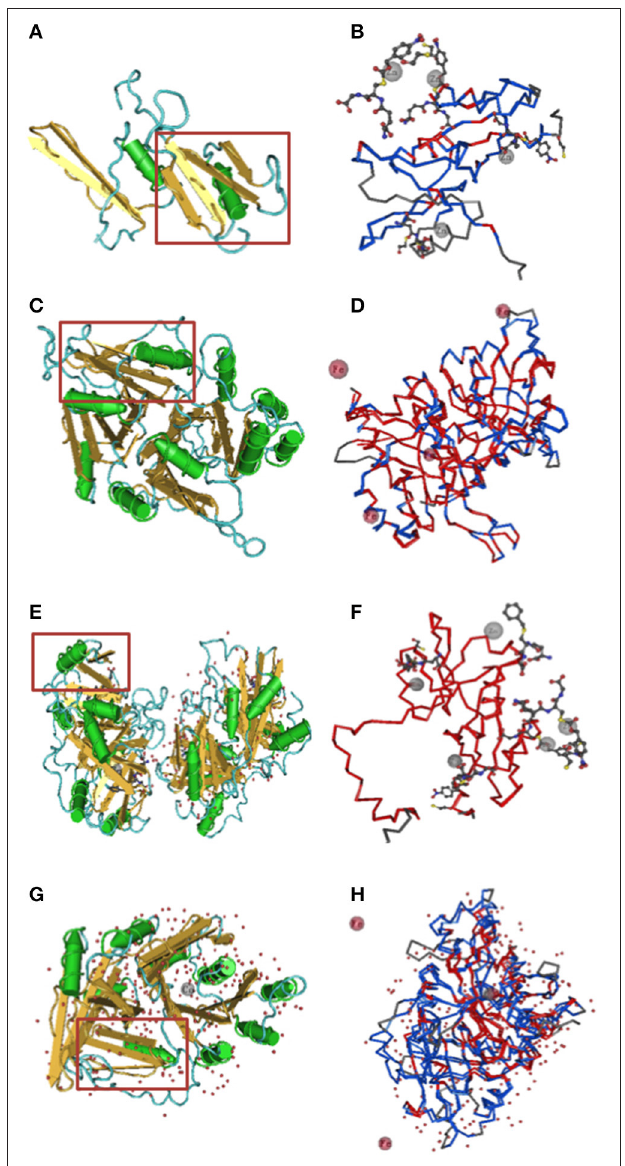
FIGURE 6 | Predictive 3D domain structure of BnaVOCs. BnGLYI19 and BnHPPD2 were selected as examples to show. The models were generated from Phyre2 with 100% of confidence. Conserved domain analysis was highlighted using VAST. (A) Predictive 3D structure of BnGLYI19. (B) Conserved domains and chelated metal ion of BnGLYI19. (C) Predictive 3D structure of BnHPPD2. (D) Conserved domains and chelated metal ion of BnHPPD2. (E) 3D structure of human GLYI. (F) Conserved domains and chelated metal ion of human GLYI. (G) 3D structure of human HPPD. (H) Conserved domains and chelated metal ion of human HPPD. Red boxes indicate a typical structure of βαβββ